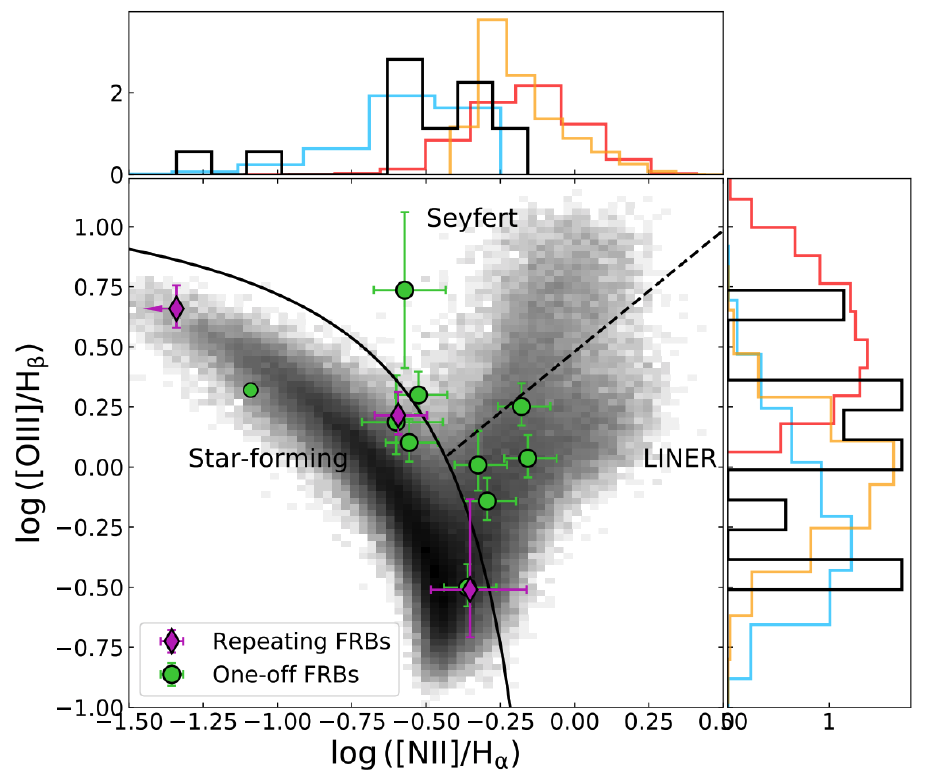
Figure 9. Emission line properties for the host galaxies of a sample of well-localised FRBs compared to star-forming galaxies, LINER galaxies, and AGN. Sample A corresponds to highly probable host-galaxy associations based on the FRB localization and galaxy photometry. Most FRB hosts are observed to lie away from star-forming main sequence and are concentrated more towards LINER galaxies. The host galaxy of FRB 121102 is an obvious outlier lying close to the tail-end of the stat-forming sequence. Figure credit: Shivani